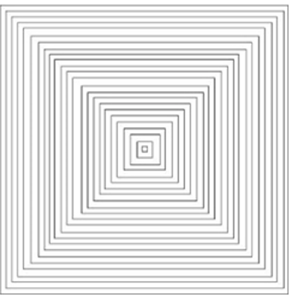
Figure 2. Schematic diagram of contour offset scanning.